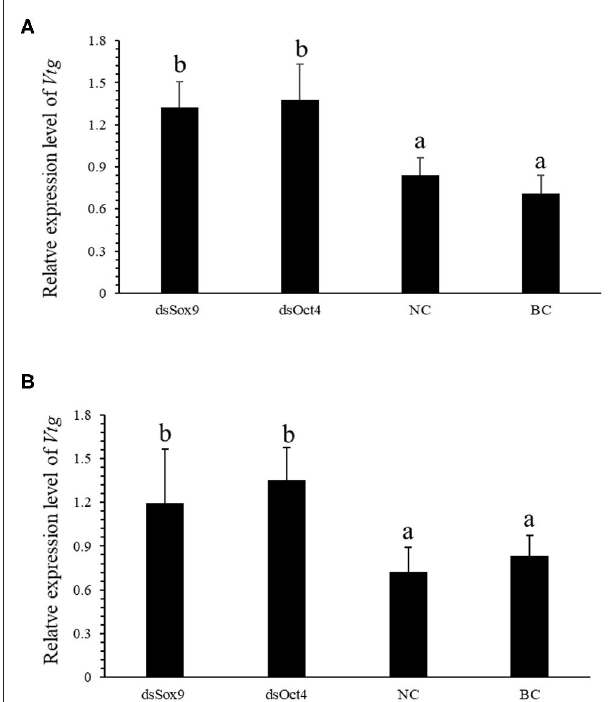
FIGURE 4 | Oct4 or Sox9 RNA interference promotes the expression level of SpVtg . (A) Relative expression of SpVtg in the ovary after injection of dsSox9, dsOct4, dsEGFP, and SPSS. (B) The relative expression of SpVtg in hepatopancreas after injection of dsSox9, dsOct4, dsEGFP, and SPSS. NC, negative control group; BC, blank control group; Bar with different letters indicates significant differences, P <